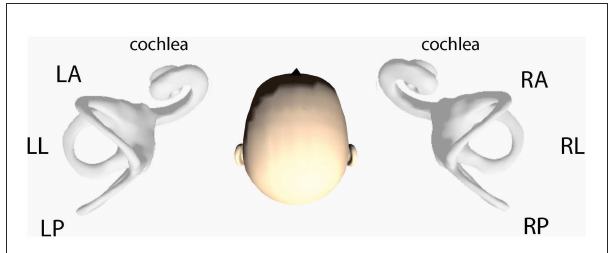
FIGURE3 Schematic representation of the orientation of the semicircular canals in the human head. There are three pairs of canals—left lateral (LL) and right lateral (RL), left anterior (LA) and right posterior (RP), and right anterior (RA) and left posterior (LP). The vertical canal pairs are referred to as RALP and LARP in the text. The canal planes are generally not mutually orthogonal and their orientation in the skull varies between individuals as we discuss below (Reproduced from iPhone app